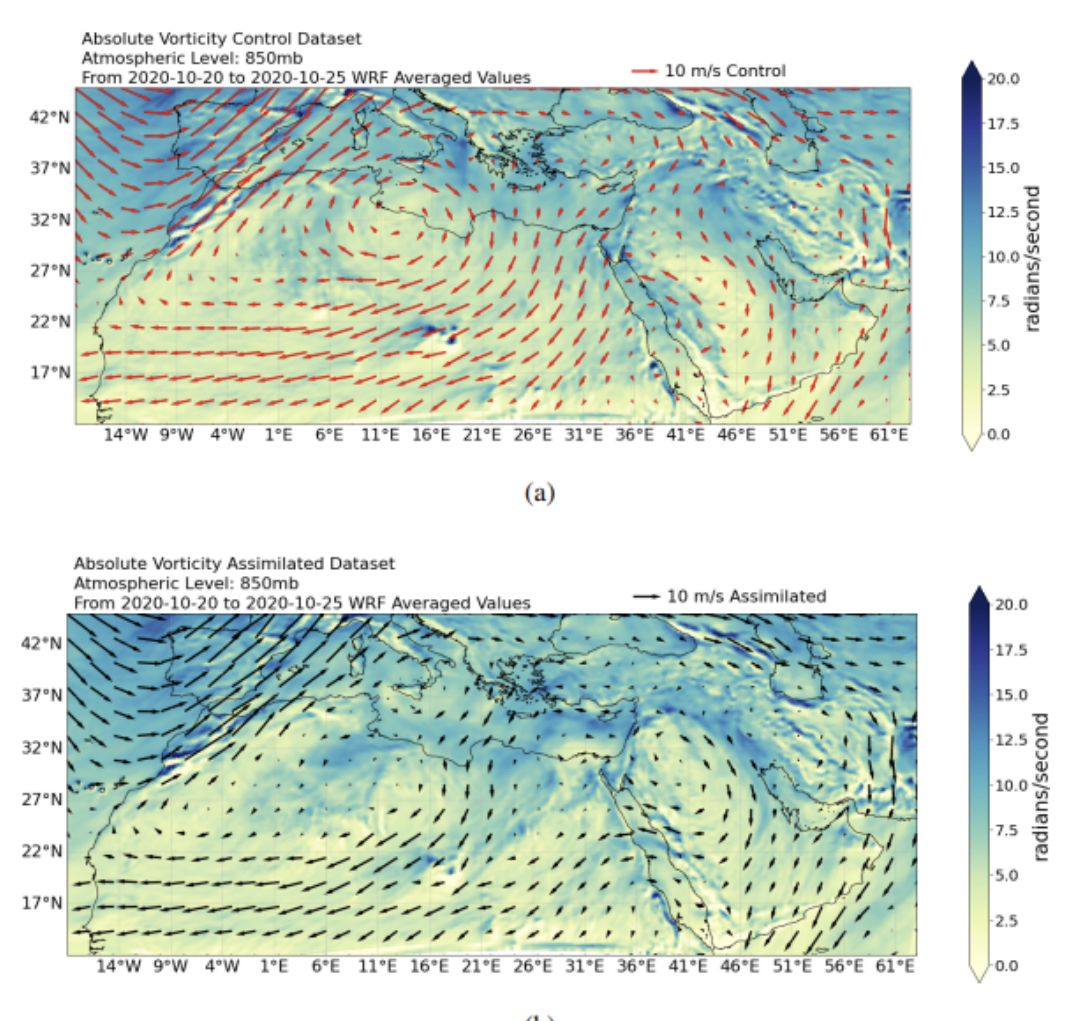
Figure A3. Comparison of model vorticity for control (a) and assimilated (b) runs (20–25 October 2020), where the wind vectors are represented in red for the control run and in black for the assimilated run.